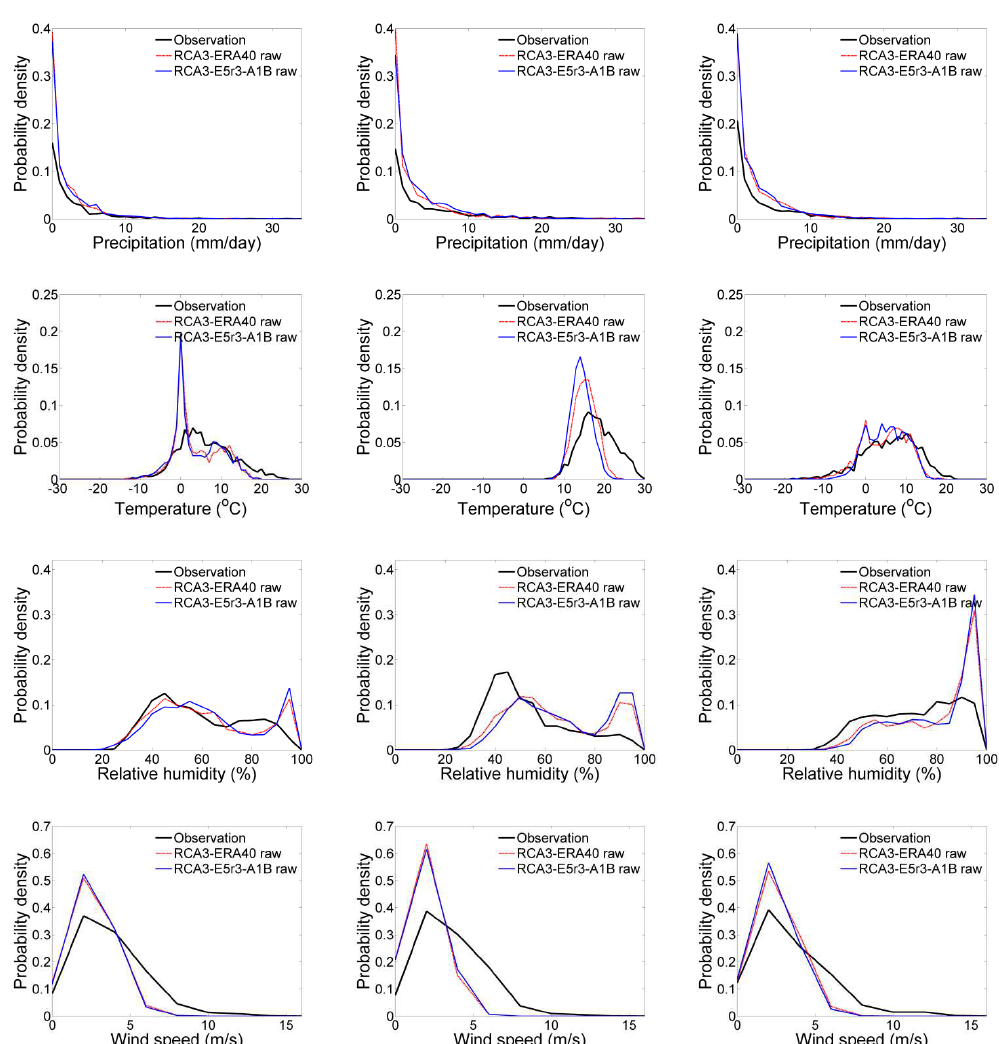
Figure 3. Probability density functions of precipitation, temperature, relative humidity and wind speed at the Edsbyn station (see Fig. 1). Comparison of observational data and raw output of the climate models RCA3-ERA40 and RCA3-E5r3-A1B (calibration period 1966–1985).